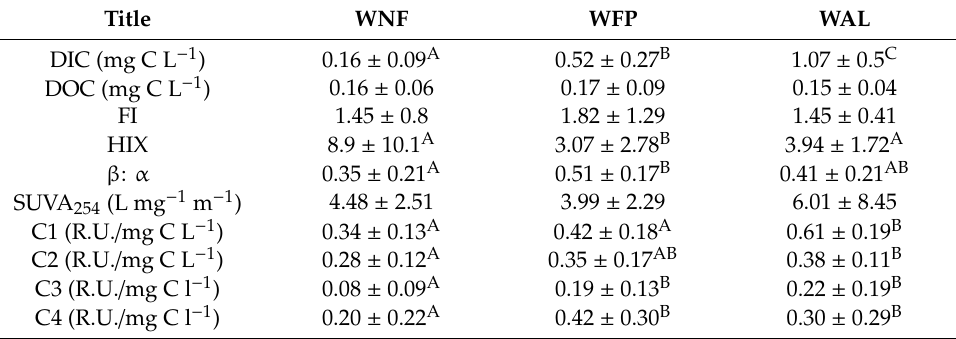
Table 3. Average ( ± standard deviation) values of Dissolved Organic Carbon (DOC) and Dissolved Inorganic Carbon (DIC) concentrations, indexes and PARAFAC components (C1, C2, C3 and C4). The intensities of fluorescence of each PARAFAC component were standardized by the DOC concentration of each sample. The statistical di ff erences among watersheds dominated by native forests (WNF), forest plantations (WFP) and agricultural lands (WAL) are shown in superscript